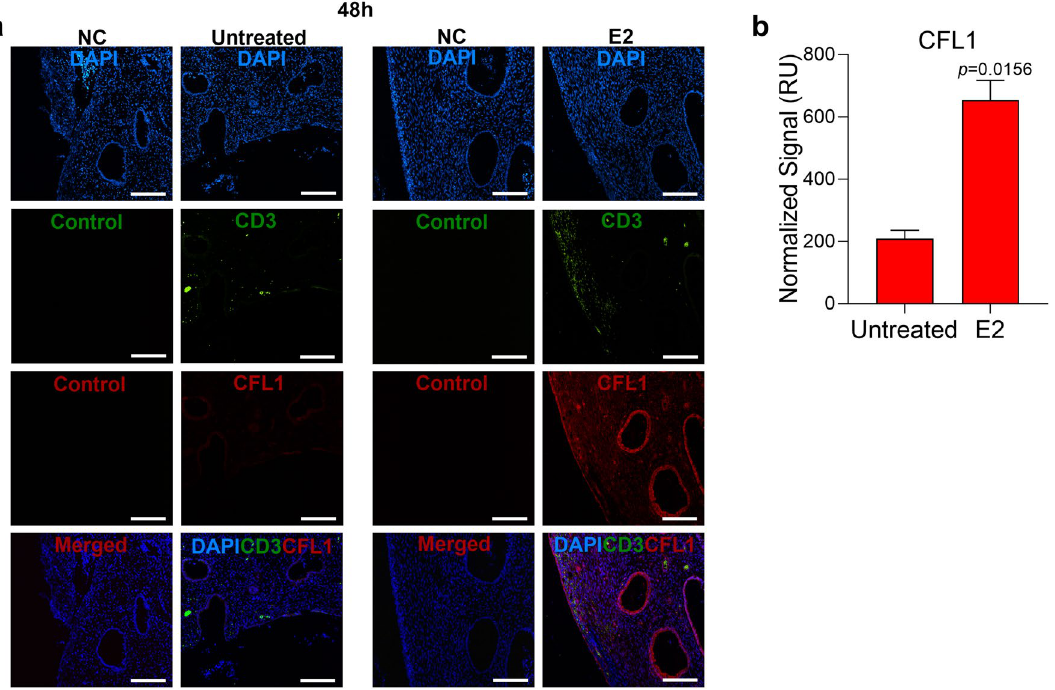
Figure 4. E2 induces CFL1 expression in uninfected endocervix. (a) Endocervical explants were incubated with E2 10,000 pg/ml (vs. untreated control) for 48 h and then paraffin embedded. The sections were stained with mouse anti-human CD3 AF488, rabbit anti-human CFL1 Ab followed by goat anti-rabbit AF568 Ab and DAPI. Rabbit IgG, goat anti-rabbit AF568 Ab and mouse IgG AF488 were used as negative controls (NC) for CFL1 and CD3 staining. Single experiment representative of 7 experiments is shown (original magnification 10X; scale bar is 100 μm). (b) Shown is the normalized fluorescence intensity of CFL1 staining in relative units (RU) (Mean ± SEM; 7